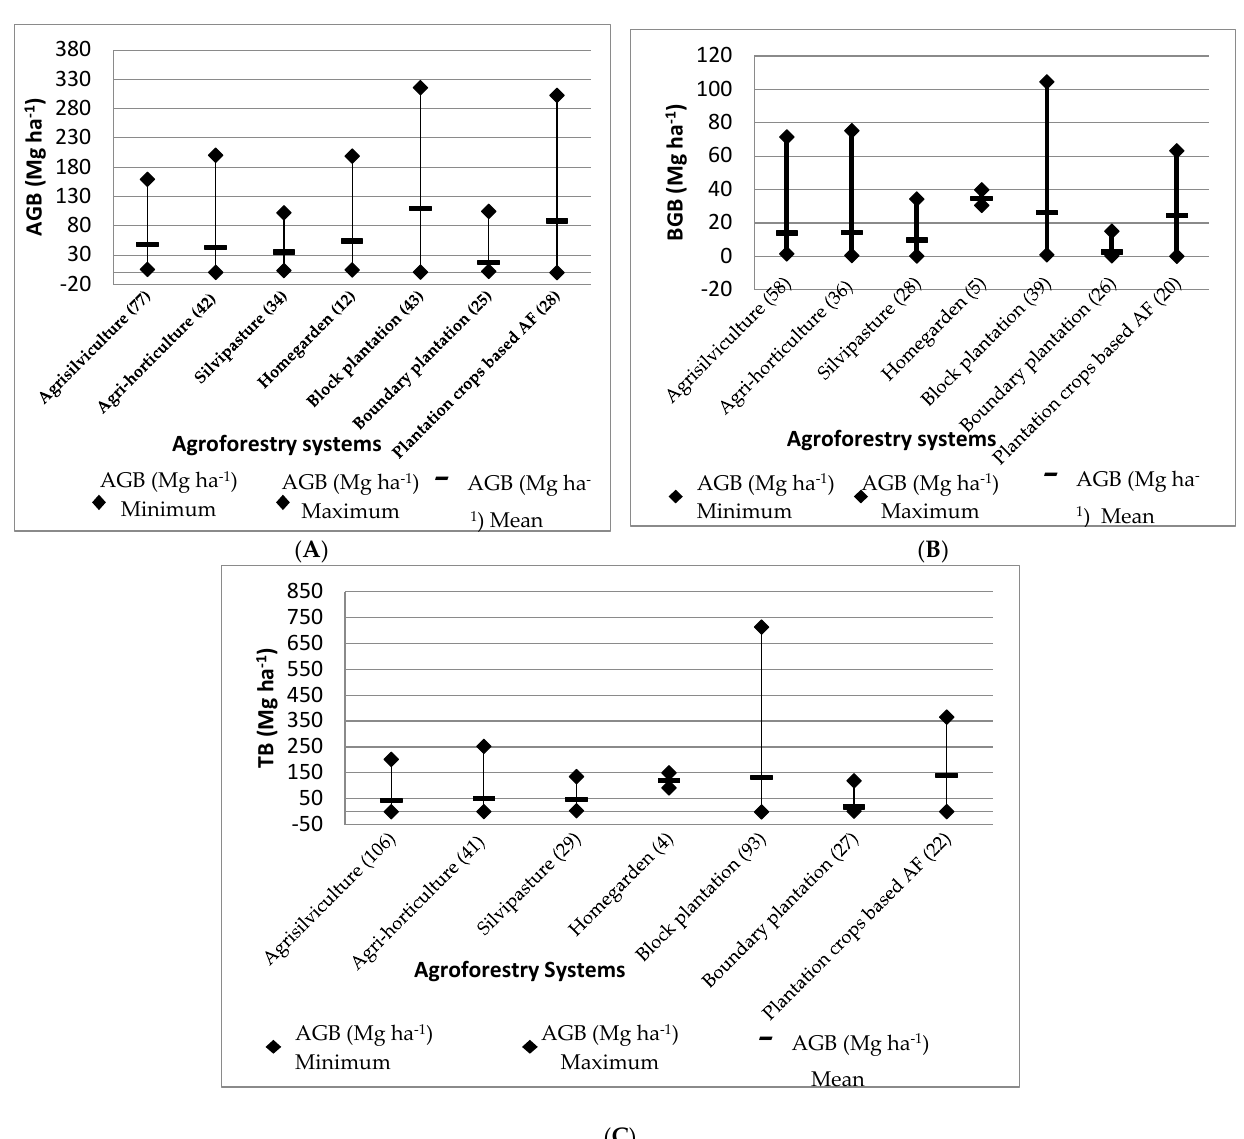
Figure 2. Range (minimum, maximum and mean) of biomass accumulation under different agro- forestry systems irrespective of region. ( A ) Above ground biomass (Mg ha − 1 ); ( B ) Below ground biomass (Mg ha − 1 ); ( C ) Total biomass (Tree+crop) (Mg ha − 1 ).